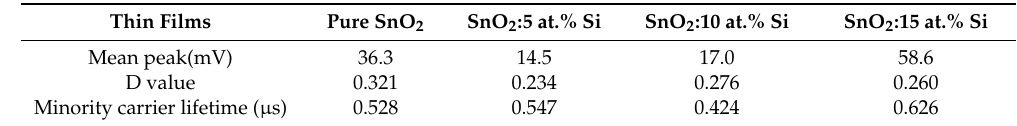
Table 2. The results of μ-PCD test of SnO 2 :Si films.